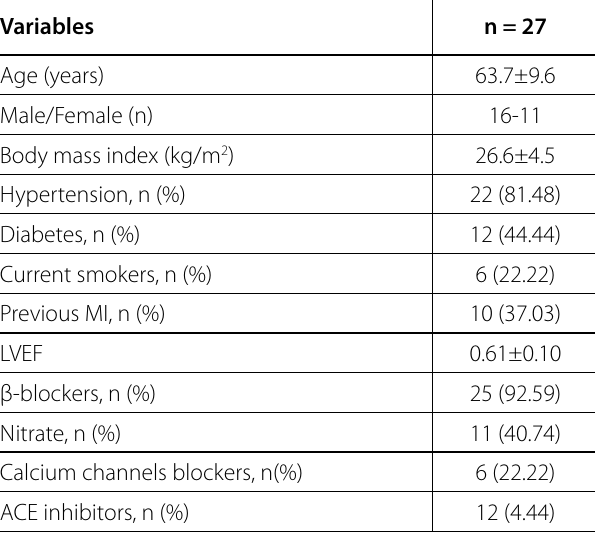
Table 1 . Demographic, clinical, and operative data of